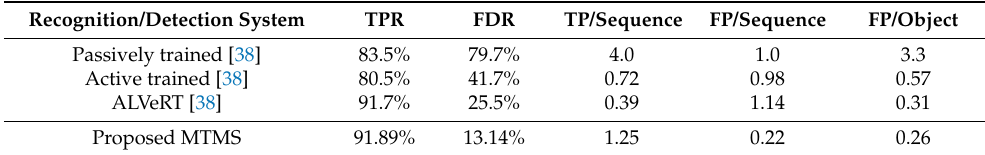
Table 2. Experimental results on LISA LDB2